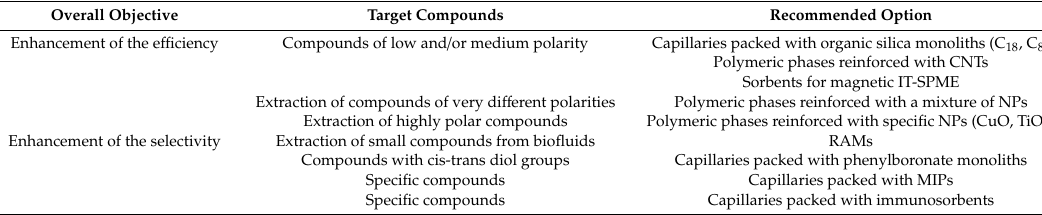
Table 2. Criteria for selecting the extractive phase for